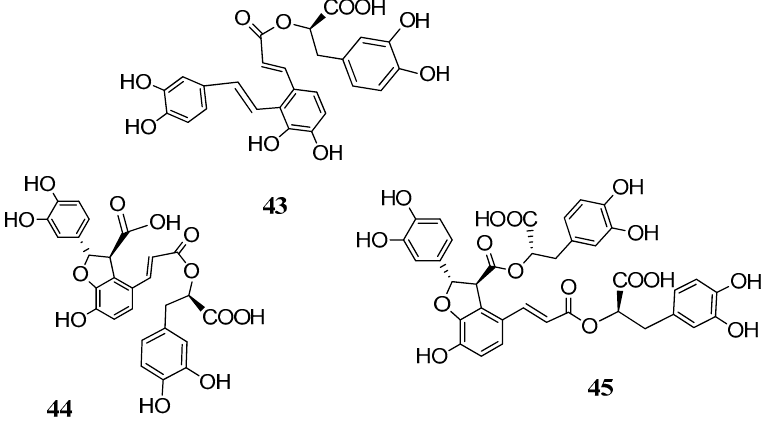
Figure 11. Structures of salvianolic acids 43 – 45 from Salvia miltiorrhiza .